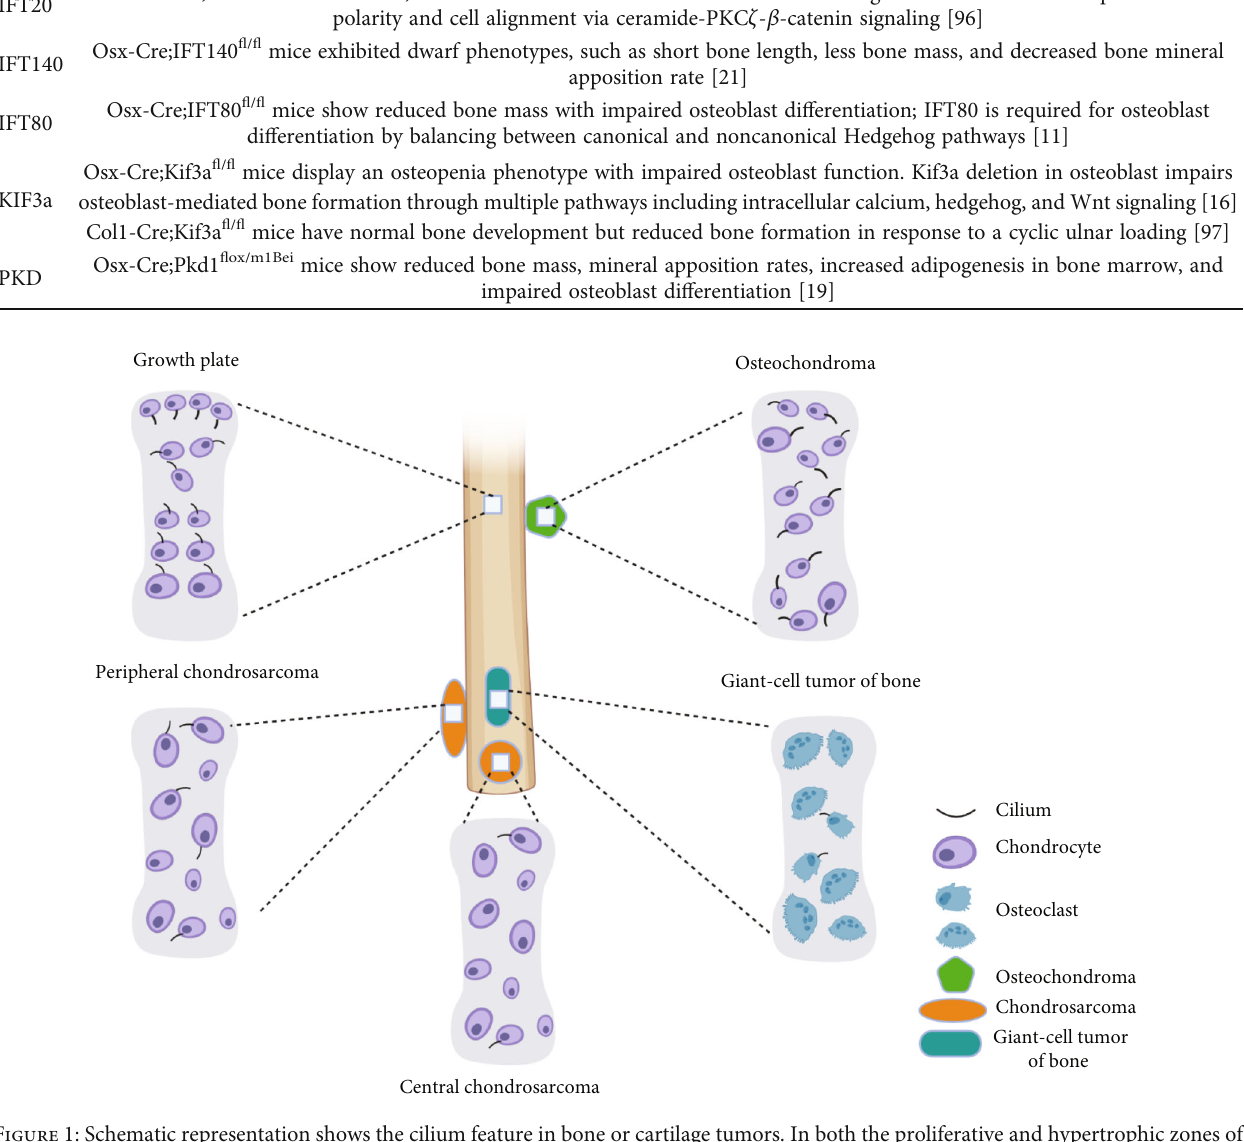
Table 1: The role of primary cilia in bone development illustrated by the conditional knock out mouse model. Gene Function IFT20